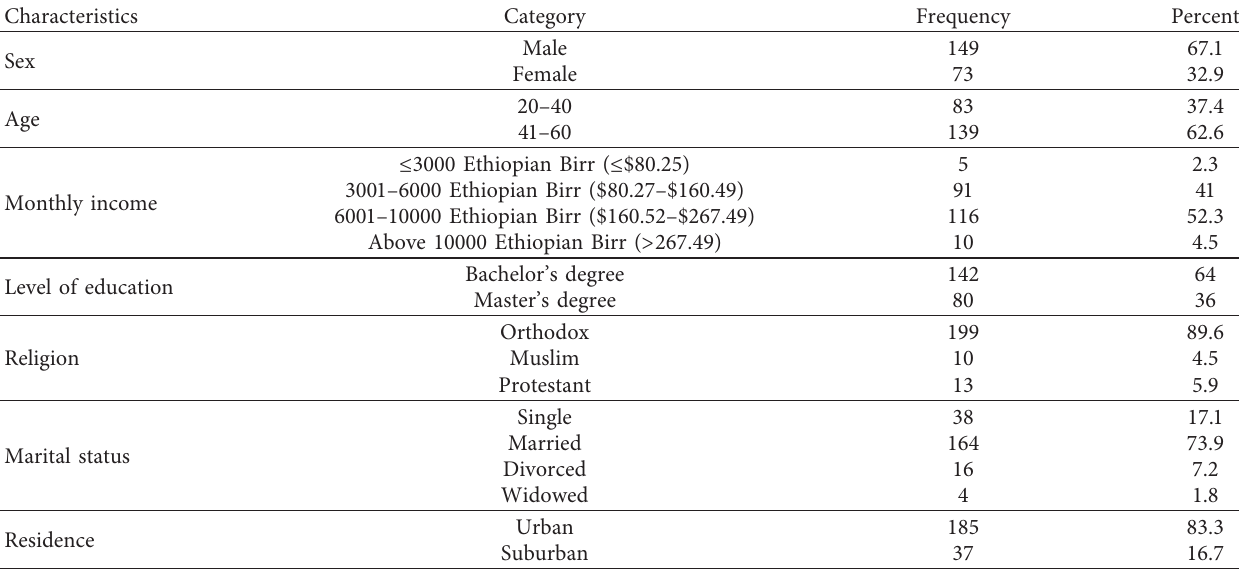
Table 1: Sociodemographic characteristics of the study participants, Bahir Dar, northwest Ethiopia, January 2020 ( n � 222). Characteristics